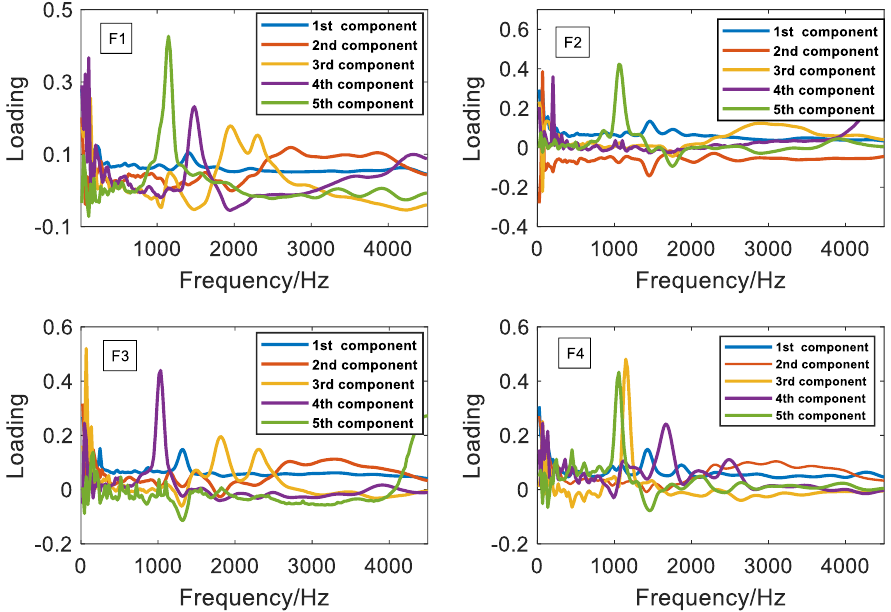
Figure 12. The 1200 rpm centrifugal pump signal decomposition in Mode 2: (F1) for normal impeller, (F2) for blade damage, (F3) for impeller edge damage, (F4) for impeller perforation damage.